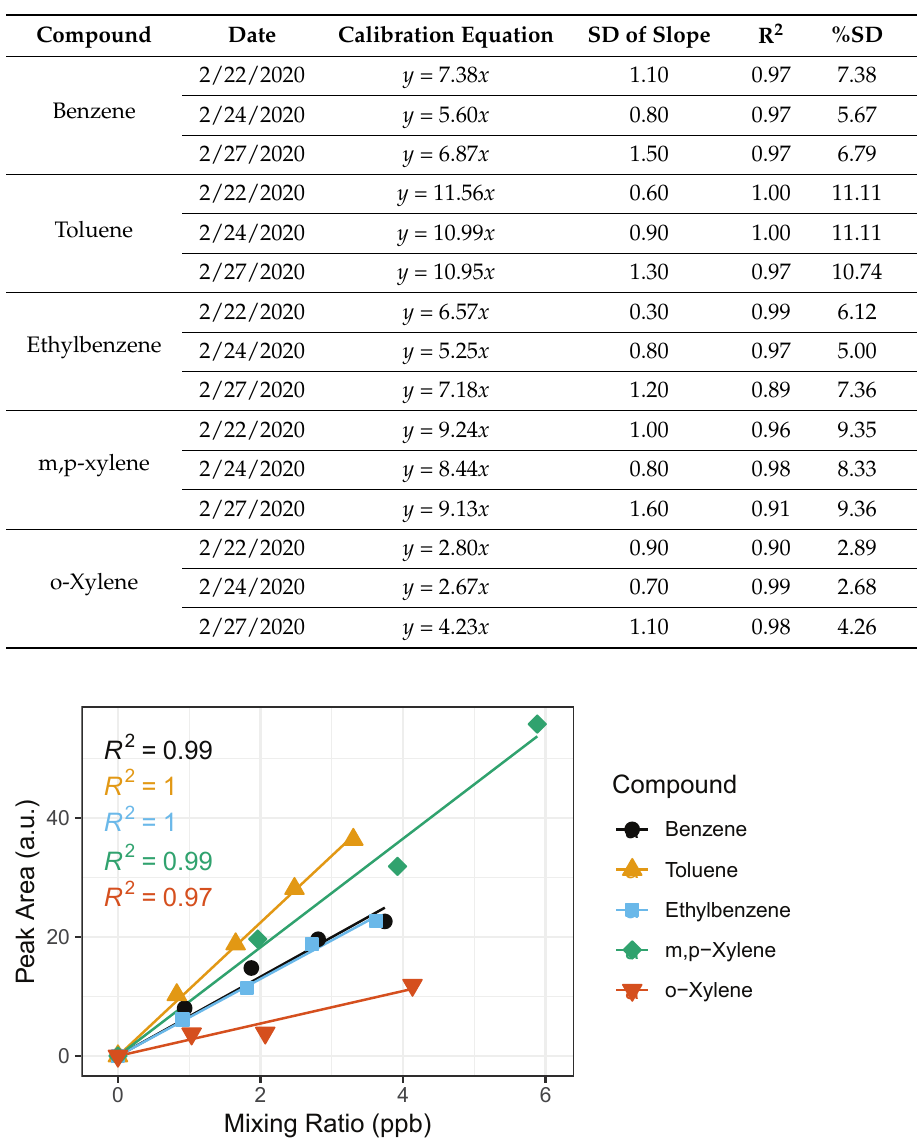
Table 2. Calibration curves for BTEX compounds. SD of slope indicates standard deviation of the slope in the calibration equation. A %SD lower than 20% indicates linearity exists in the calibration curve. N represents the number of points in the curve.